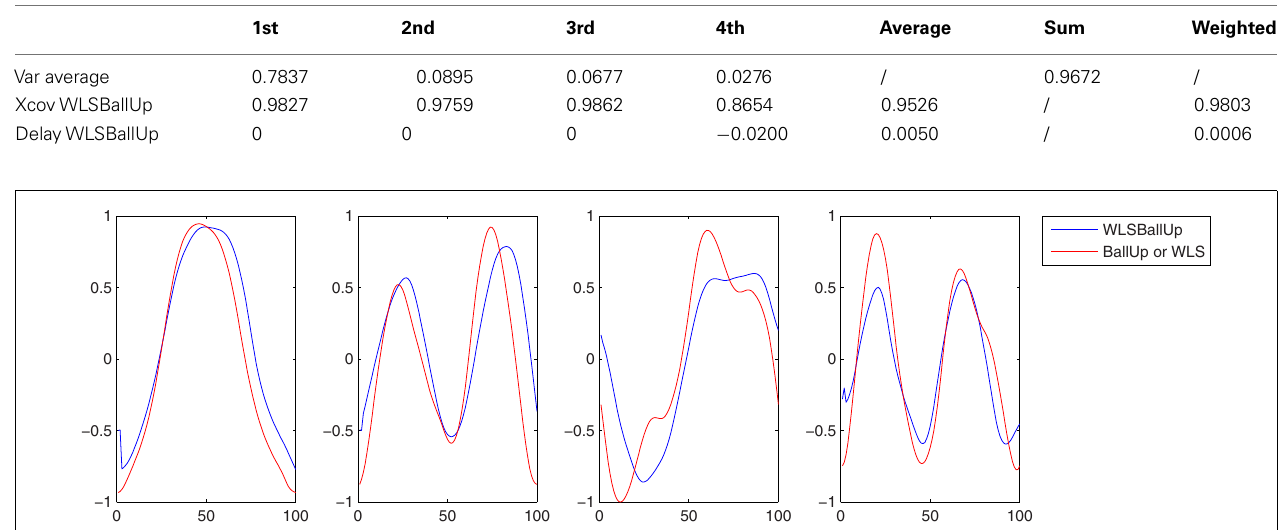
Table 9 | Reaching a target with the left and the right hand while walking (2 subjects).